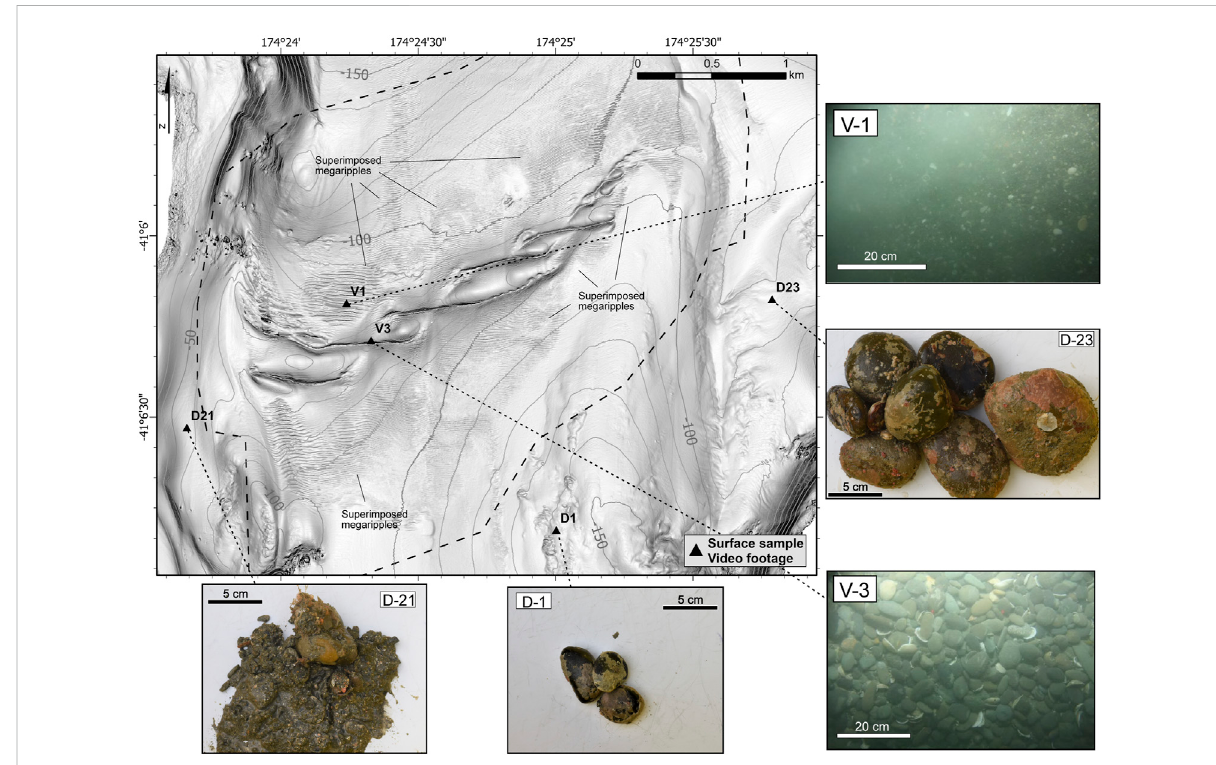
FIGURE 3 Map of thebedforms fi eld located SE ofthe Cape Koamaru (see location in Figure 1)indicating thelocation of sampling sites and video footage, withphotographsofthesedimentsamplesandsea fl oorimages.Dashedblack linelimitsthere-mappedareaand10 mcontourdepthsareshownas thin grey lines. Greyscale shaded relief uses slope (rather than hillshade) to represent sea fl oor features, to reduce bias from arti fi cial light source elevation and